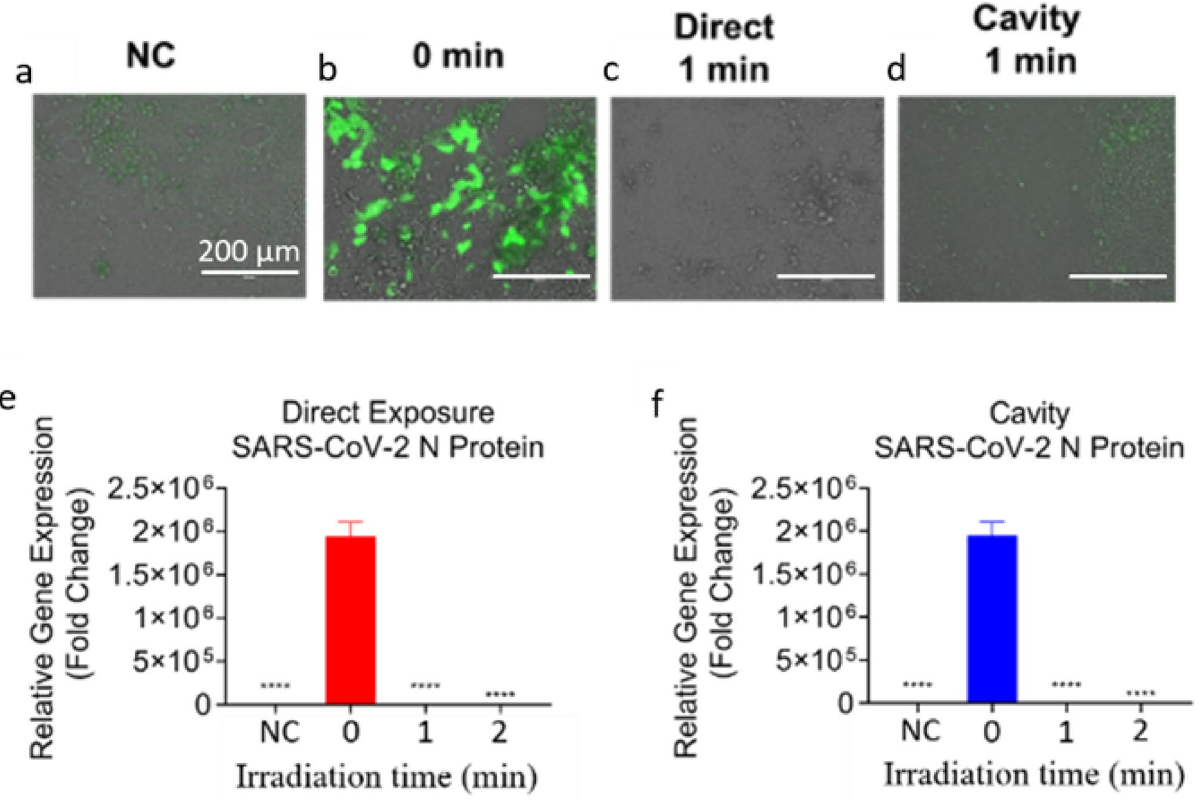
Figure 4. Reinfection of Calu-3 cells with culture supernatant from SARS-CoV-2 infected Calu-3 cells that were exposed to direct or cavity UVC laser light (Fig. 3). ( a – d ) Images were taken 48 h post-infection using EVOS microscope (Thermo Fisher). 200X. Scale bar = 200 µm. ( e – f ) SARS-CoV-2 N protein expression in Calu-3 cells. At 48 h post-infection RNA was extracted and qPCR performed. Average fold change ± SEM, compared to the negative control (NC), is shown (N = 3). A 1-Way ANOVA and Dunnett’s post hoc test was used to determine significance compared to 0 s. * p < 0.05, ** p < 0.01, *** P < 0.001, **** P < 0.0001.